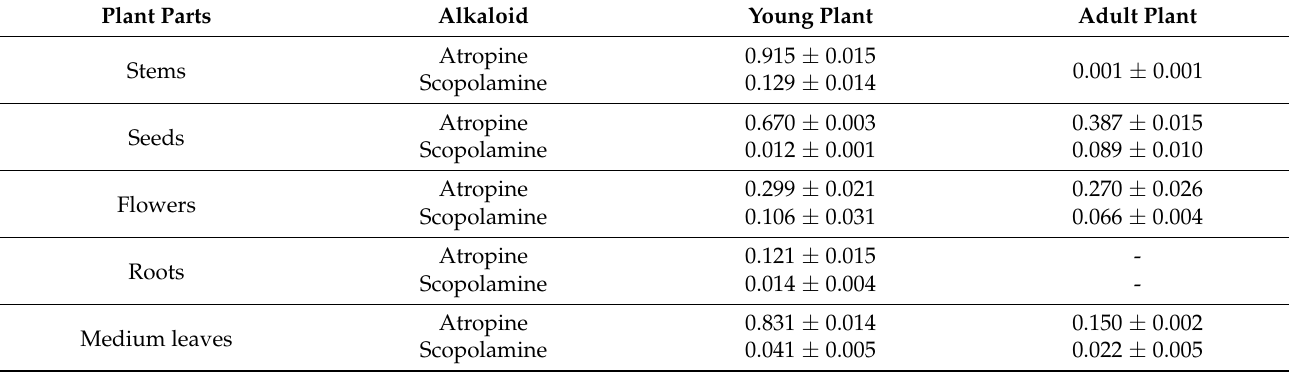
Table 2. Concentration ( µ g/mg) of atropine and scopolamine in different plant parts of D. stramonium. Plant